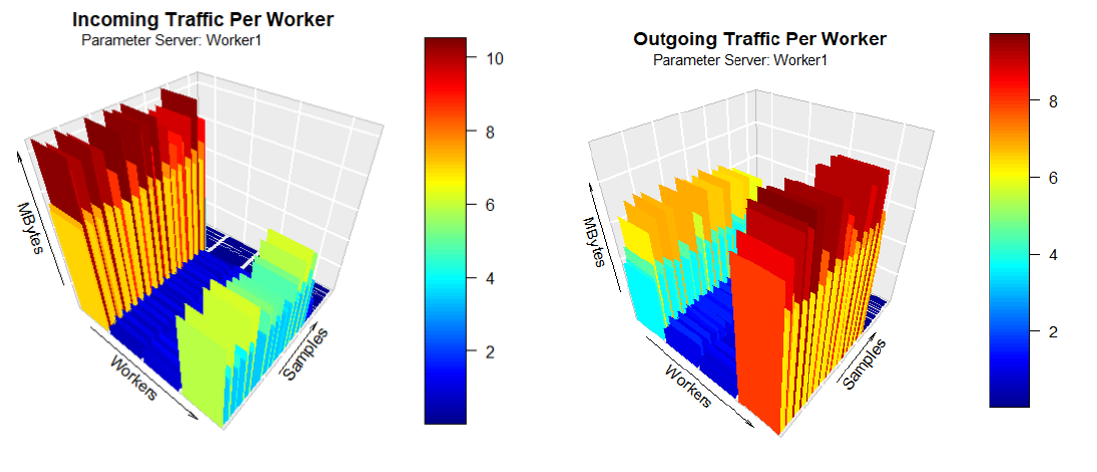
Figure 11. Communication traffic per worker for the ’baseline’